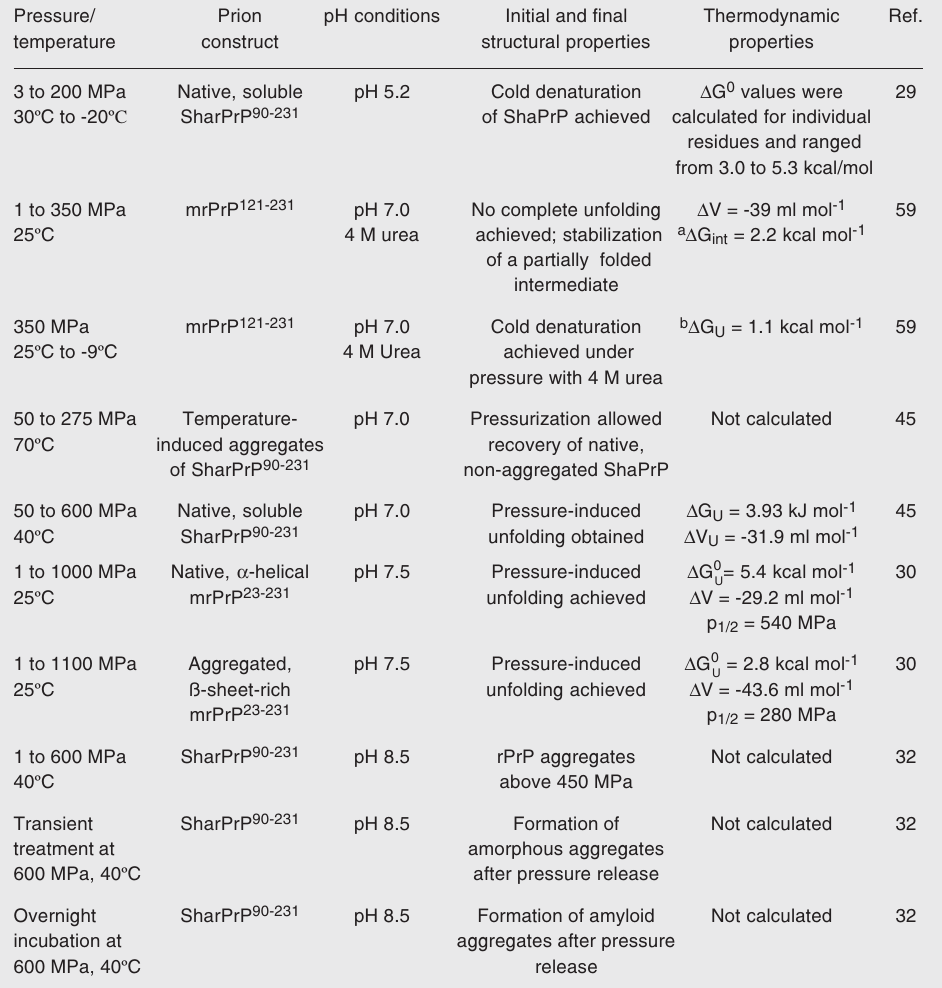
Table 1. Overview of prion isoforms characterized by high